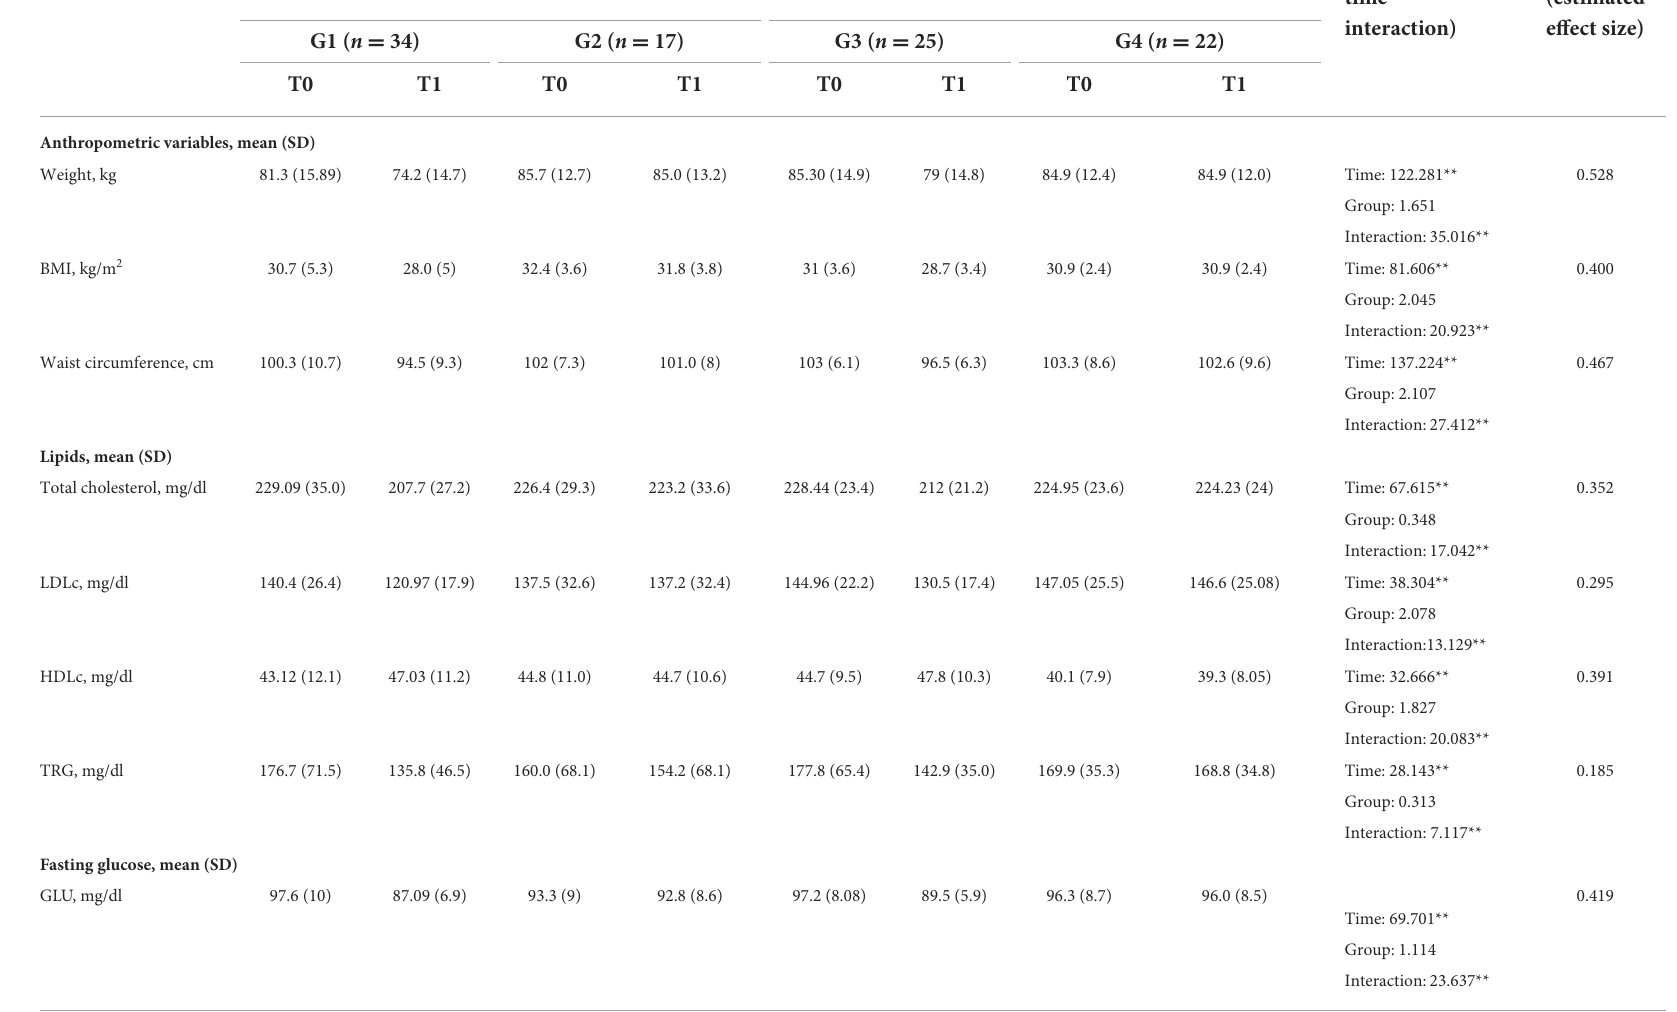
TABLE 2 Anthropometric and metabolic variables upon entry into the study (T0) and at the 12-month follow-up (T1).